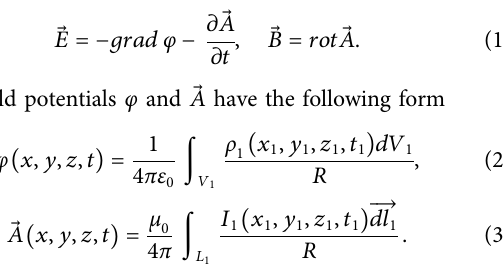
Frontiers in Nanotechnology |